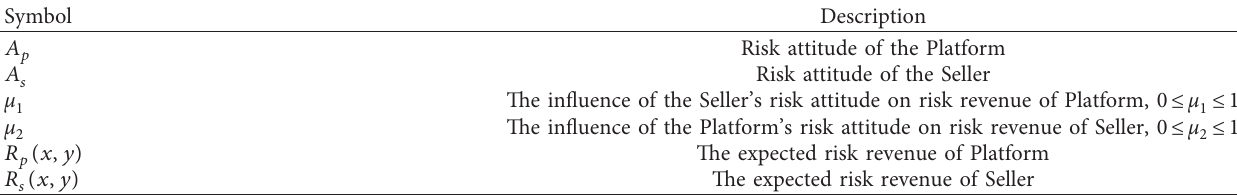
Table 3: Symbols and descriptions of parameters for Model II.